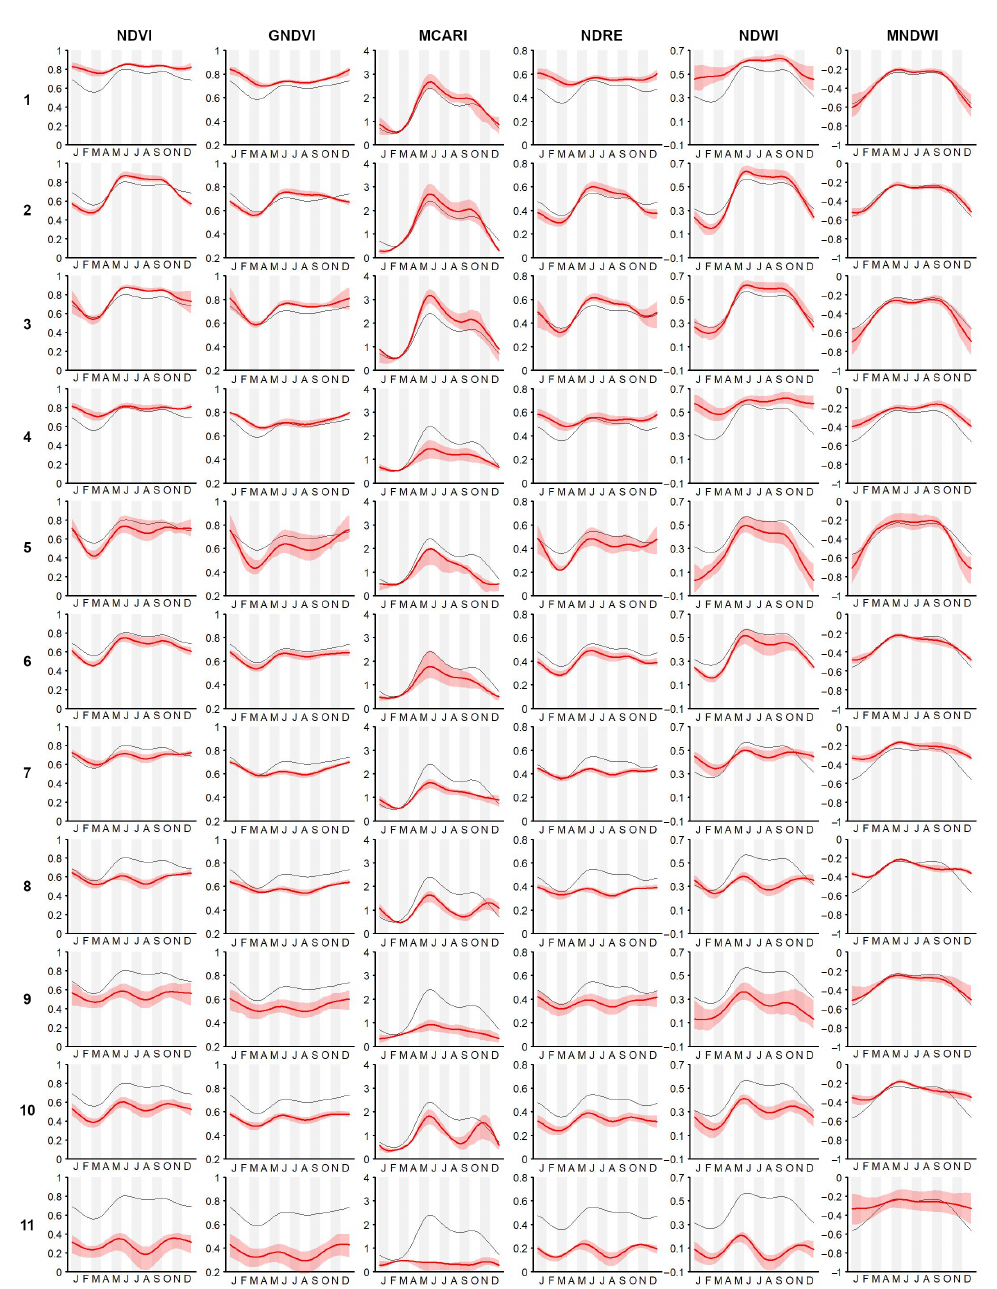
Figure A3. Seasonal temporal profiles of the target classes in the different spectral vegetation indices. The plotted MCARI values are scaled by a factor of 1000. The bold red line is the mean vegetation index value. The red polygon is the 10–90th percentile. The black line is the mean vegetation index values of whole study area (which is useful to appreciate the differences between the target class and mean of the study area). Row numbers correspond to the plant associations and habitats listed